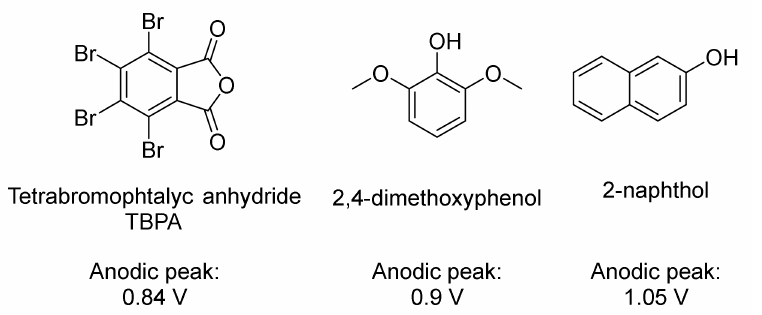
Figure 6. Oxidation potential of TBPA, 2,6-dimethylphenol, 2-naphthol. CV conditions: 0.1 mol/L LiClO 4 /CH 3 CN; Pt disk w. e.; Ag wire c. e.; Ag/AgNO 3 0.1 mol/L in CH 3 CN ref.